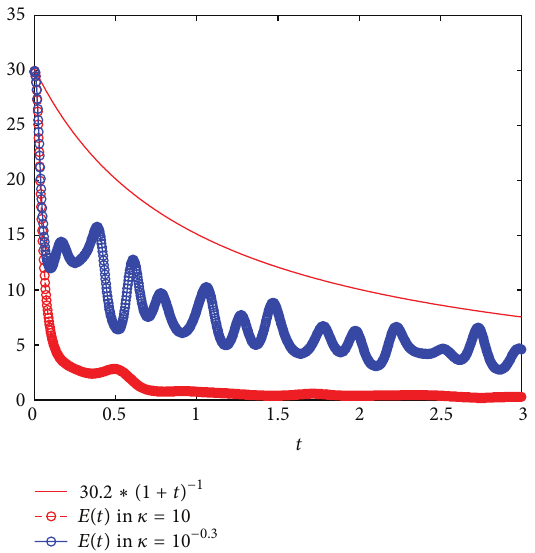
Figure 2: Algebraic decay rates of the energy in case of 𝜅 = 10 and 𝜅 = 10 −0.3